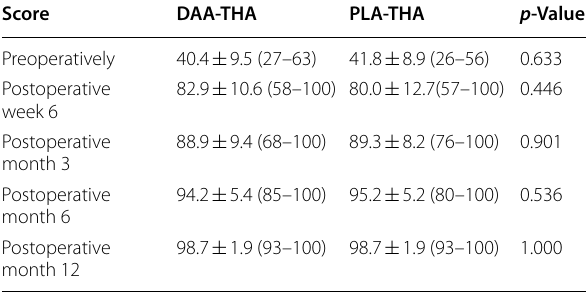
Table 5 HSS of the two